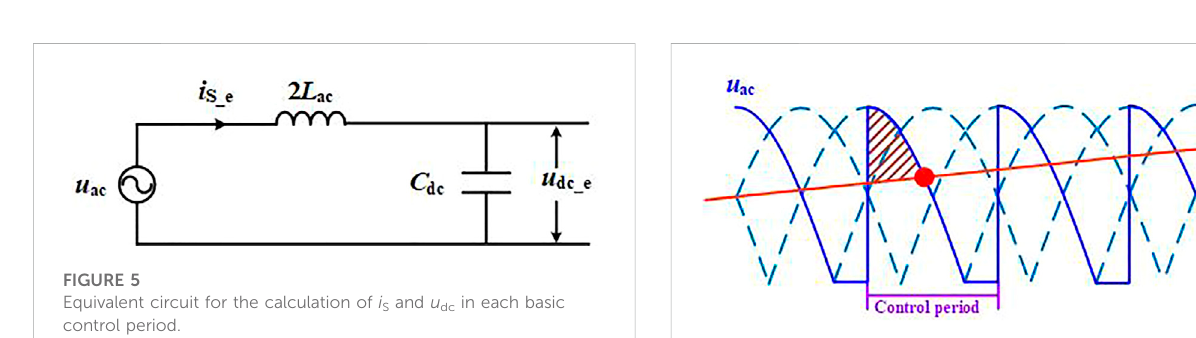
FIGURE 6 Typical waveforms of u ac and u dc when α = 90 °